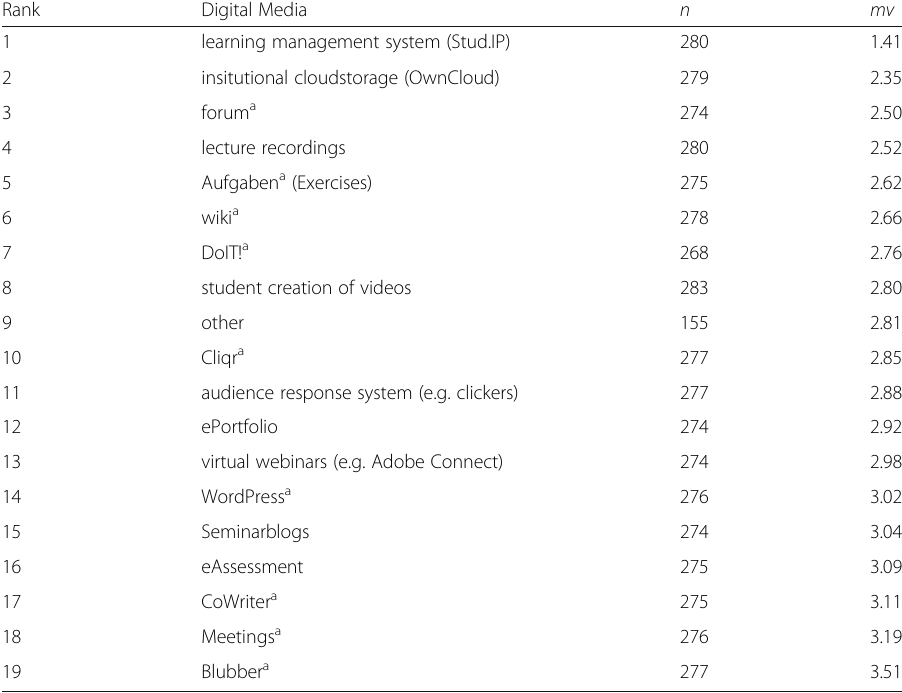
Table 2 Ranking by mean - ‘ How useful do you find the following tools for your teaching? ’